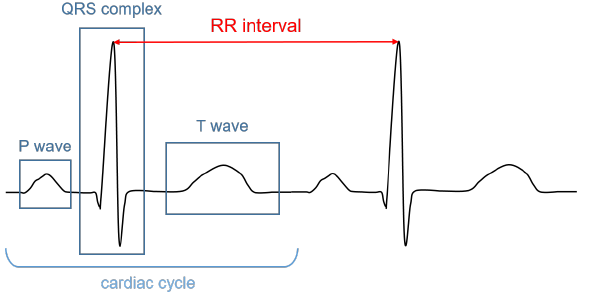
Figure 1. Illustrative ECG signal recorded during one cardiac cycle. The main components are